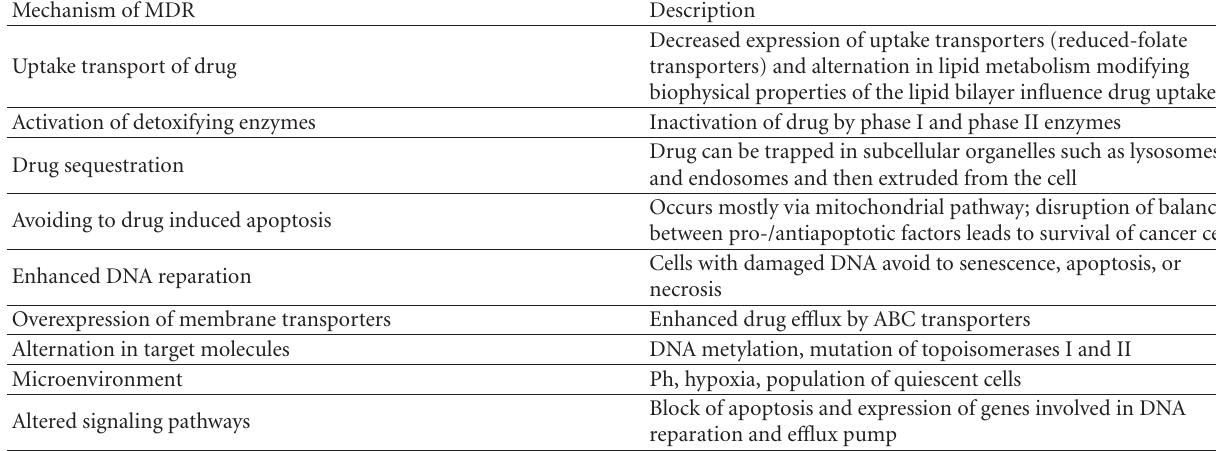
Table 1: Summary of mechanisms of MDR [5,